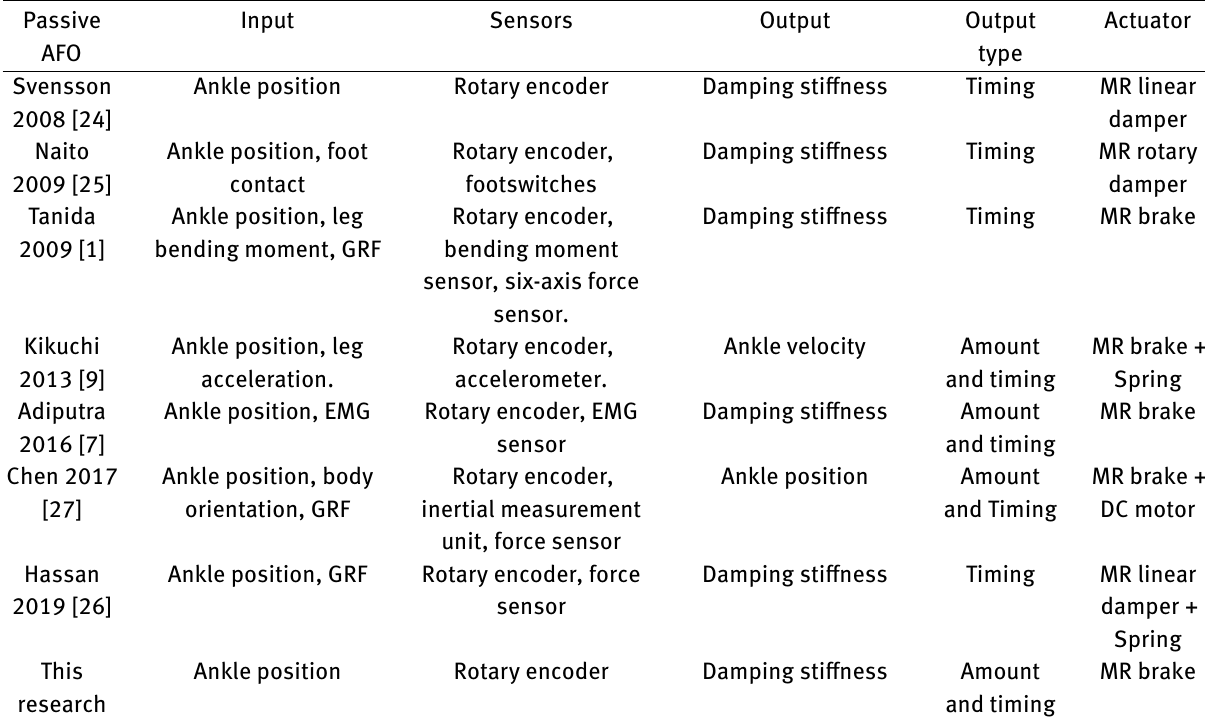
Table 2: Input and output of the control system for passive AFO with MR actuators